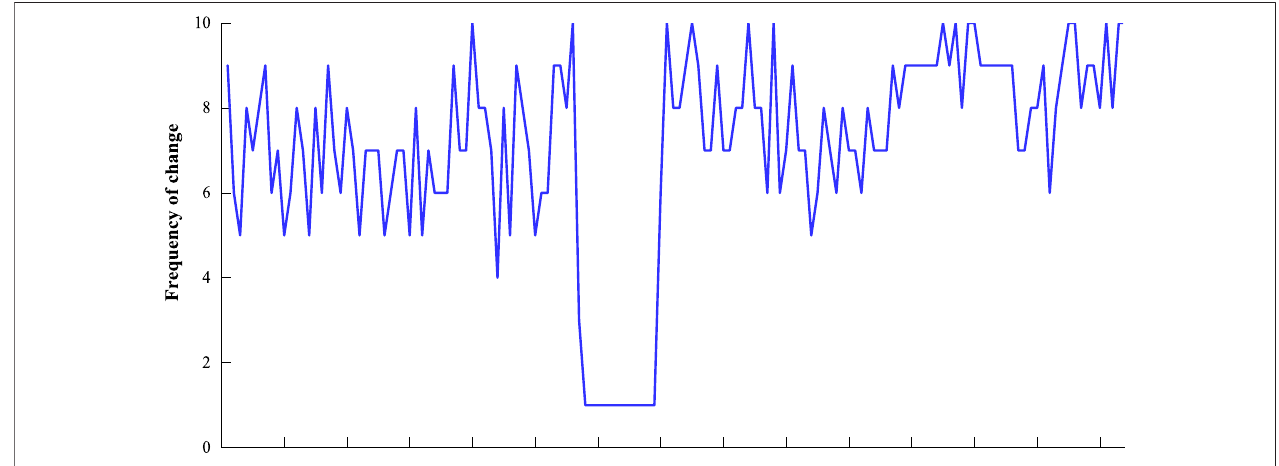
FIGURE 12 | Gas emission quantity frequency of change curve.